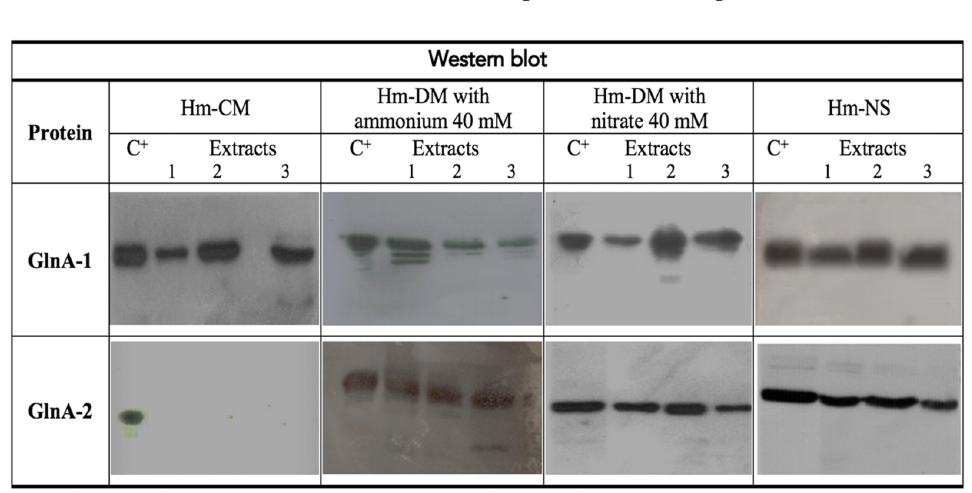
Figure 5. Expression of the GlnA proteins in the presence of different concentrations of putrescine by Western blotting. The positive control (C + ) corresponds to the recombinant protein of GlnA-1 and GlnA-2 proteins.